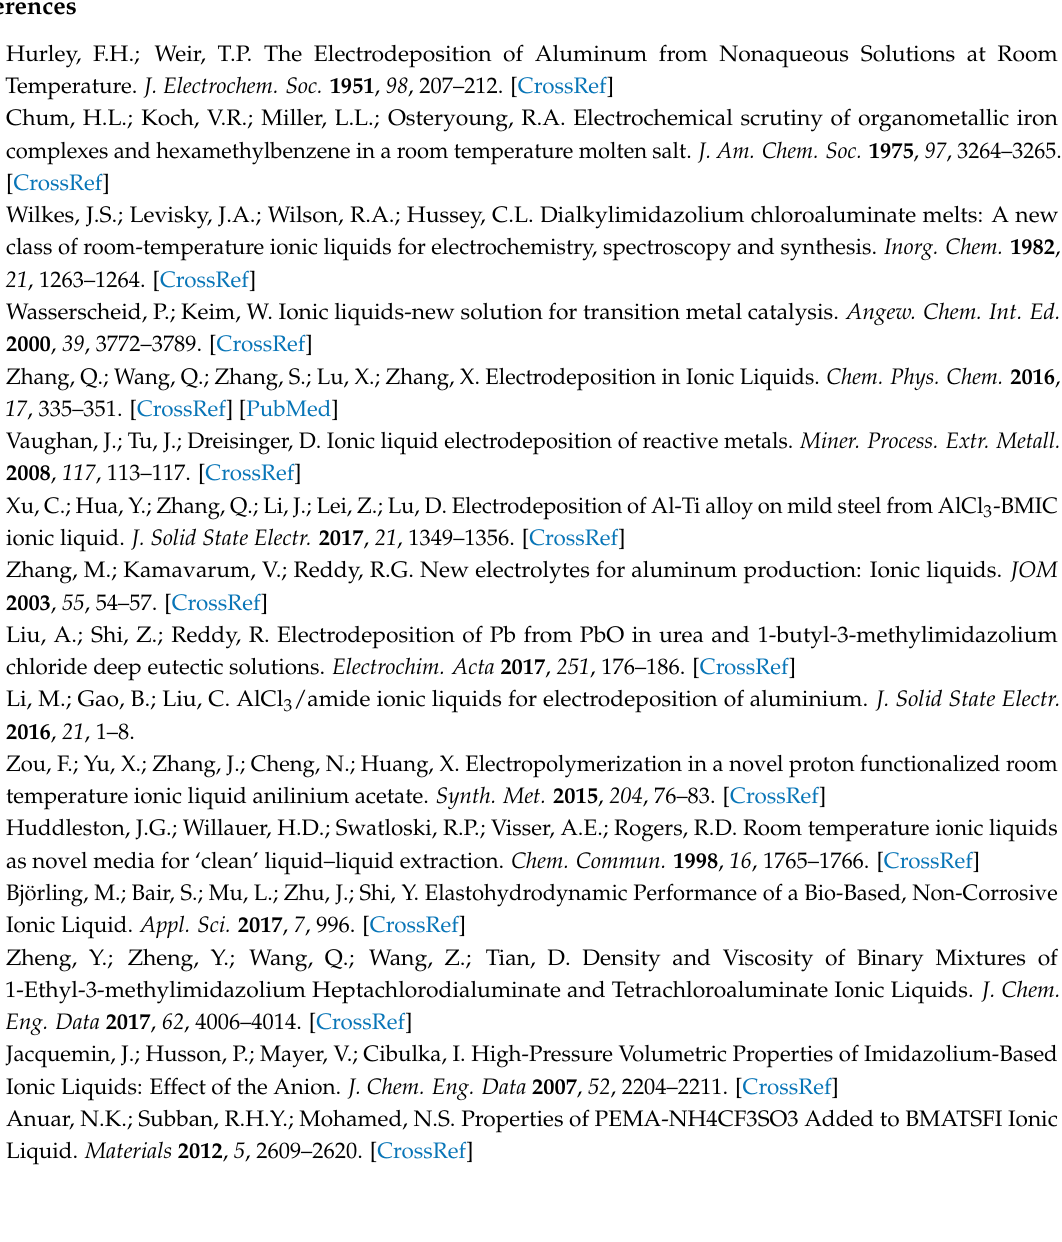
Table S1: Density of [EMIm]F at different temperatures. Table S2: Viscosity of [EMIm]F at different temperatures. Table S3: Conductivity of [EMIm]F at different